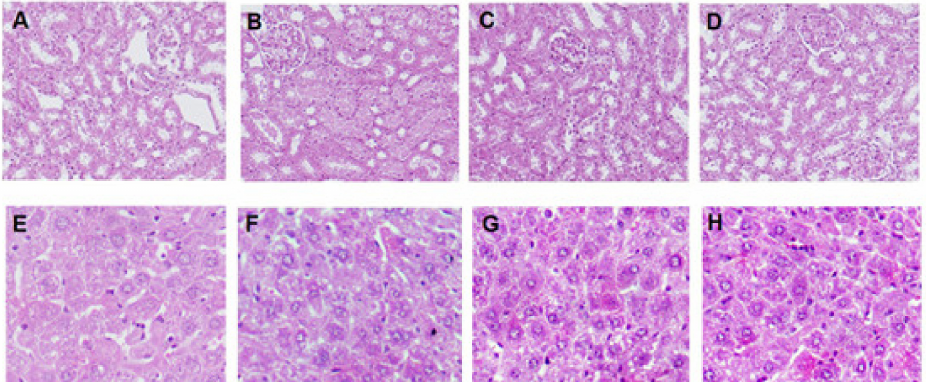
Figure 5. The extent of toxicity visualized on kidney and liver tissue sections of healthy mice after administering 2C-L and 2C-FL formulations. Representative histopathological images of kidney sections: ( A ) free 2C, ( B ) 2C-F, ( C ) 2C-L, and ( D ) 2C-FL; liver sections: ( E ) free 2C, ( F ) 2C-F, ( G ) 2C-L, and ( H ) 2C-FL at 200 × magnification.